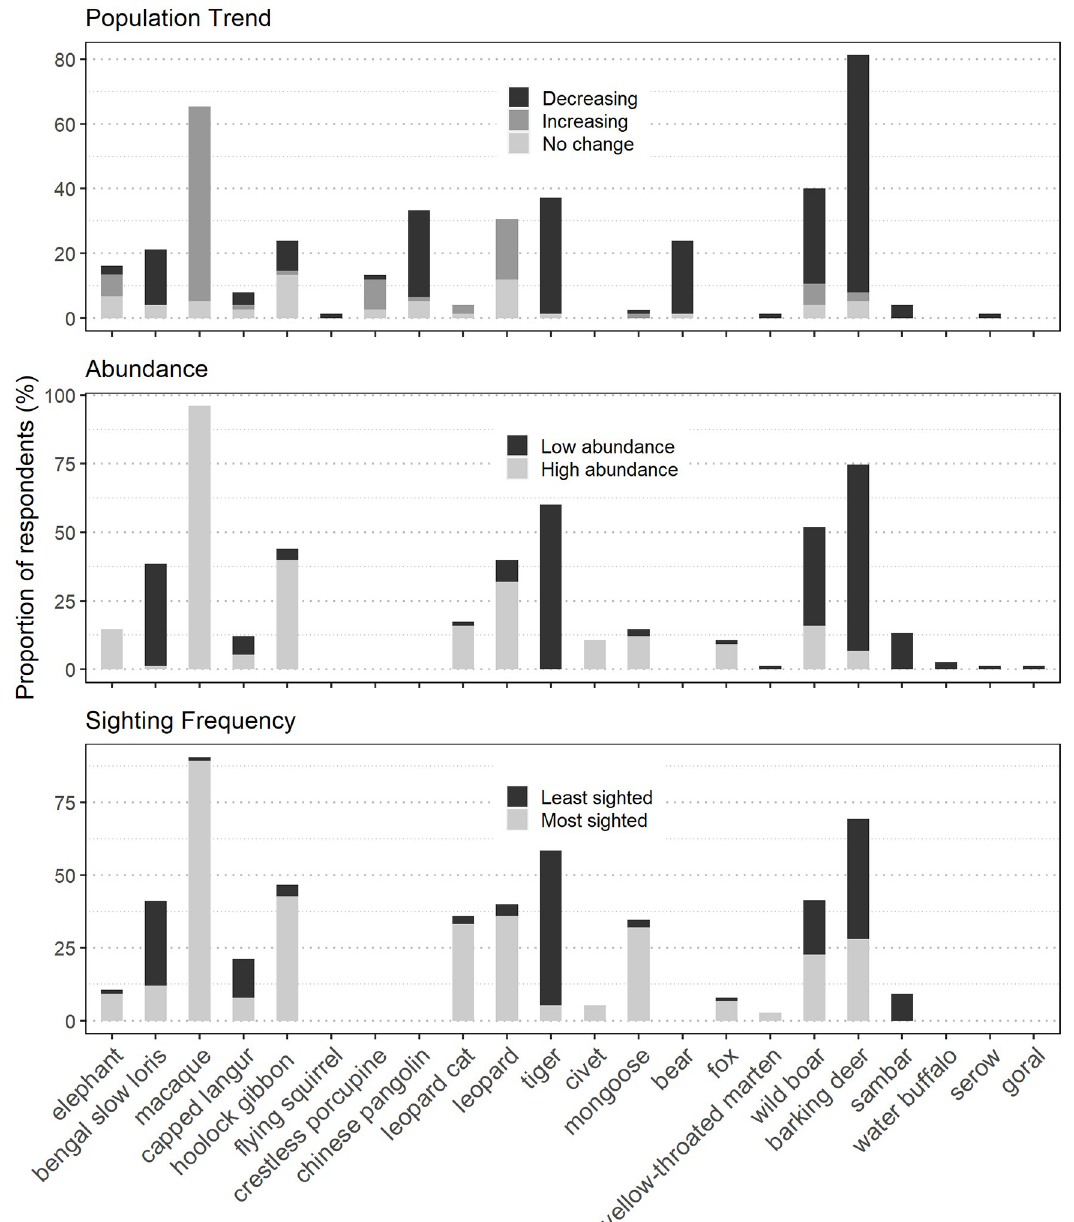
Fig 5. Respondents’ perceptions on population trend, species abundance and their frequency of sighting species in select CRs of Ri Bhoi